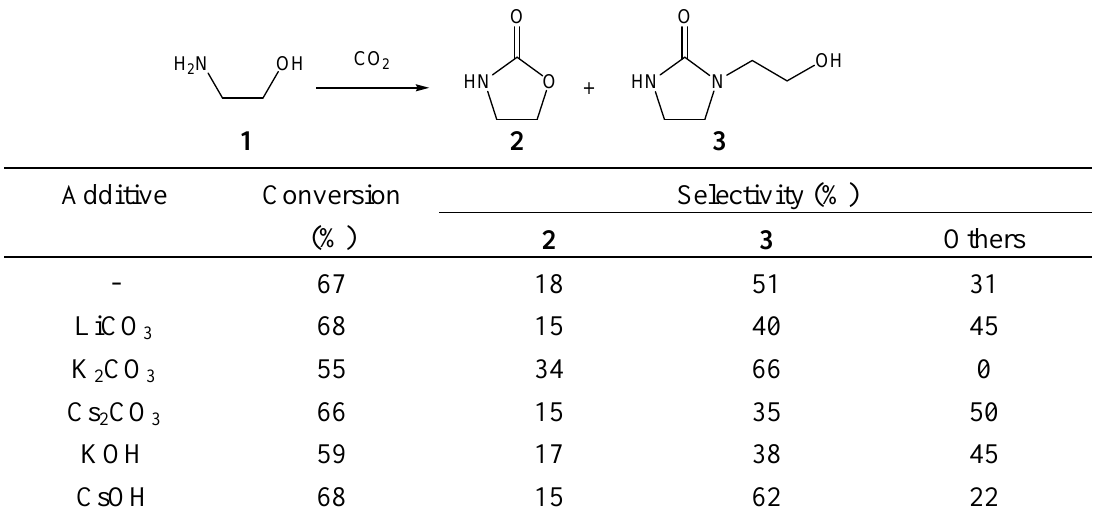
Table 2. Additive effects of alkaline carbonates and hydroxides on the reaction a of 2-aminoethanol 1 and carbon dioxide in the presence of BMIM-Br